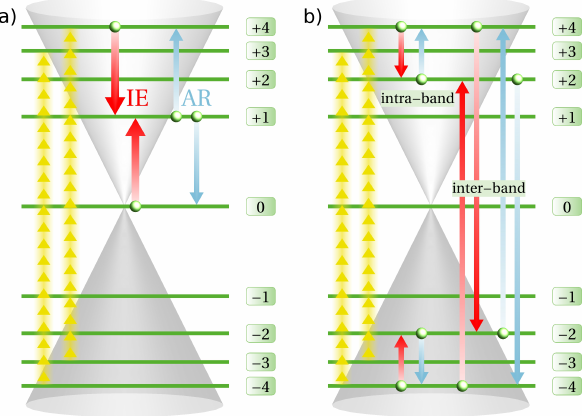
Figure 16: Pumping scheme for carrier multiplication. Two sketches of the low-energetic Landau levels in graphene with the Dirac cone in the background, where the yellow arrows indicate the opti- cal excitation with linear polarized light inducing the transitions LL ∓ 4 (cid:29) LL ±3 . (a) Carriers excited to LL +4 can participate in a pro- cess called impact excitation (IE) which dominates against its in- verse process called Auger recombination (AR). This leads to the excitation of an additional carrier from LL 0 to LL +1 . (b) Intra- and in- terband scattering channels between electrons that do not affect an occupation change, since they occur with the same probability as their respective inverse processes (cf. the red and blue arrows).